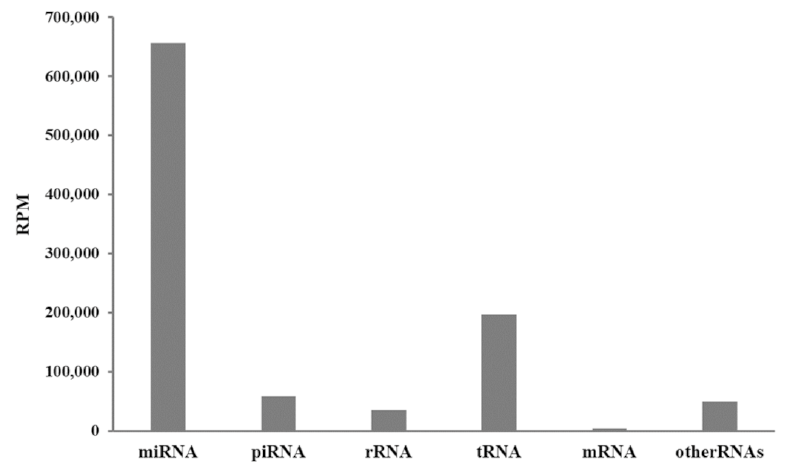
Figure 1. Mean small RNA and microRNA (miRNA) abundance in reads per million (RPM) of the milk samples collected from healthy and mastitic cows.